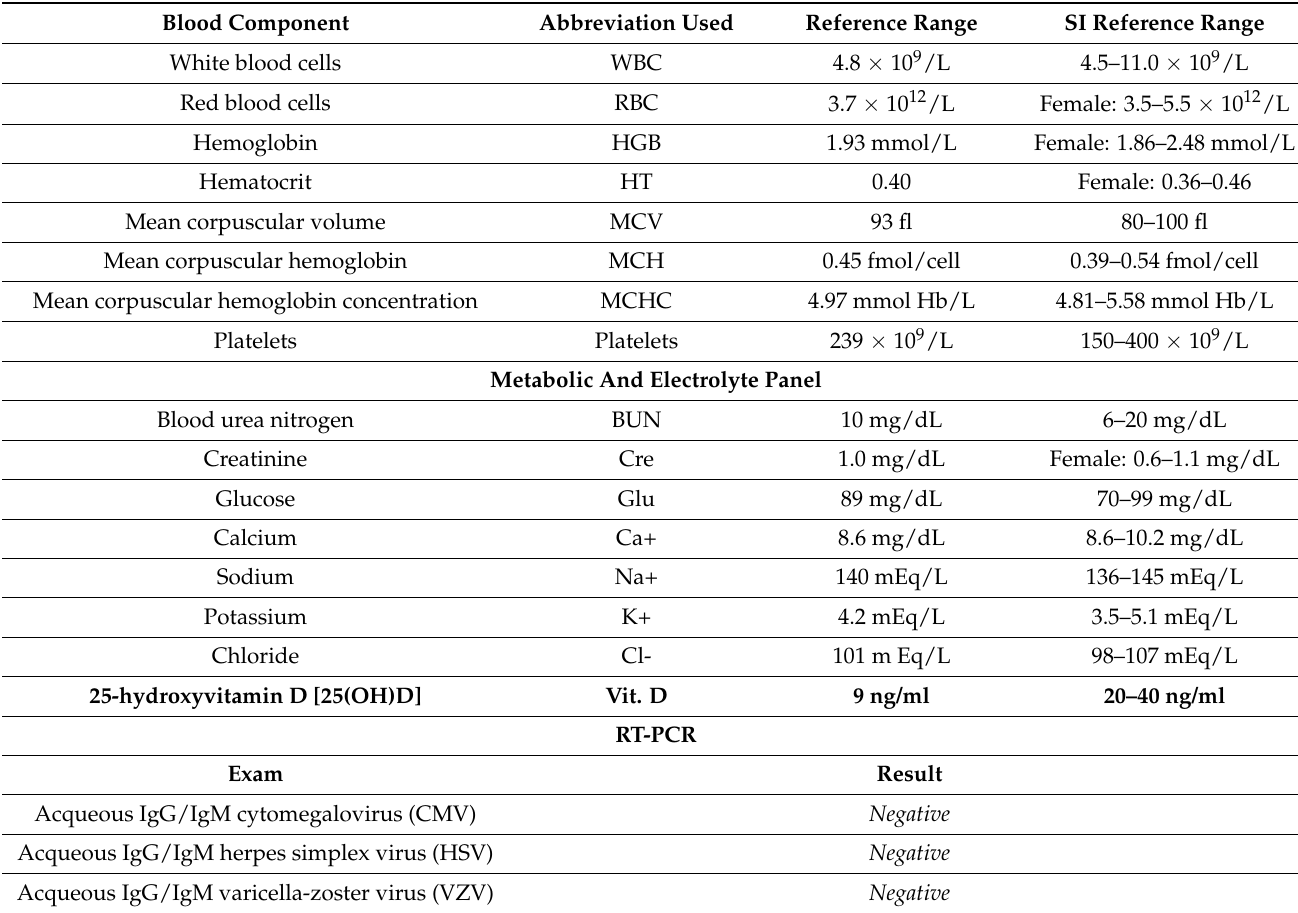
Table 2. Blood exams of the patient. Abnormal data are indicated in